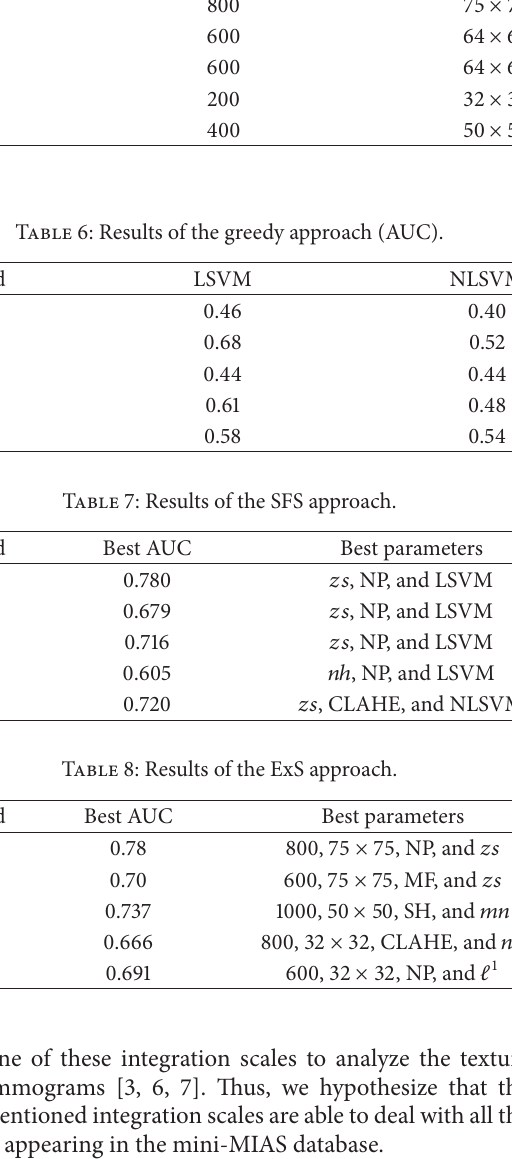
Table 5: The best option of pixel resolution, integration scale, preprocessing, and normalization methods with each texture method. Method